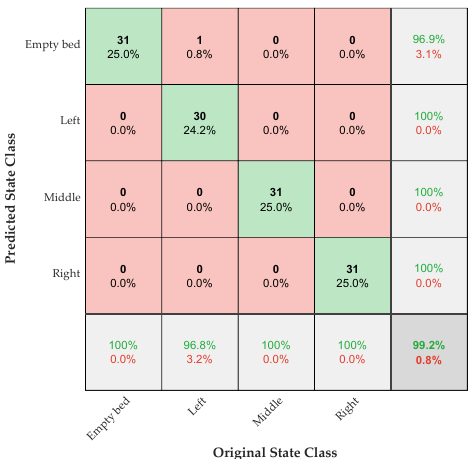
Figure 11. Classification accuracy for each sleeping state, represented by a Confusion Matrix for the Bi-LSTM layer.